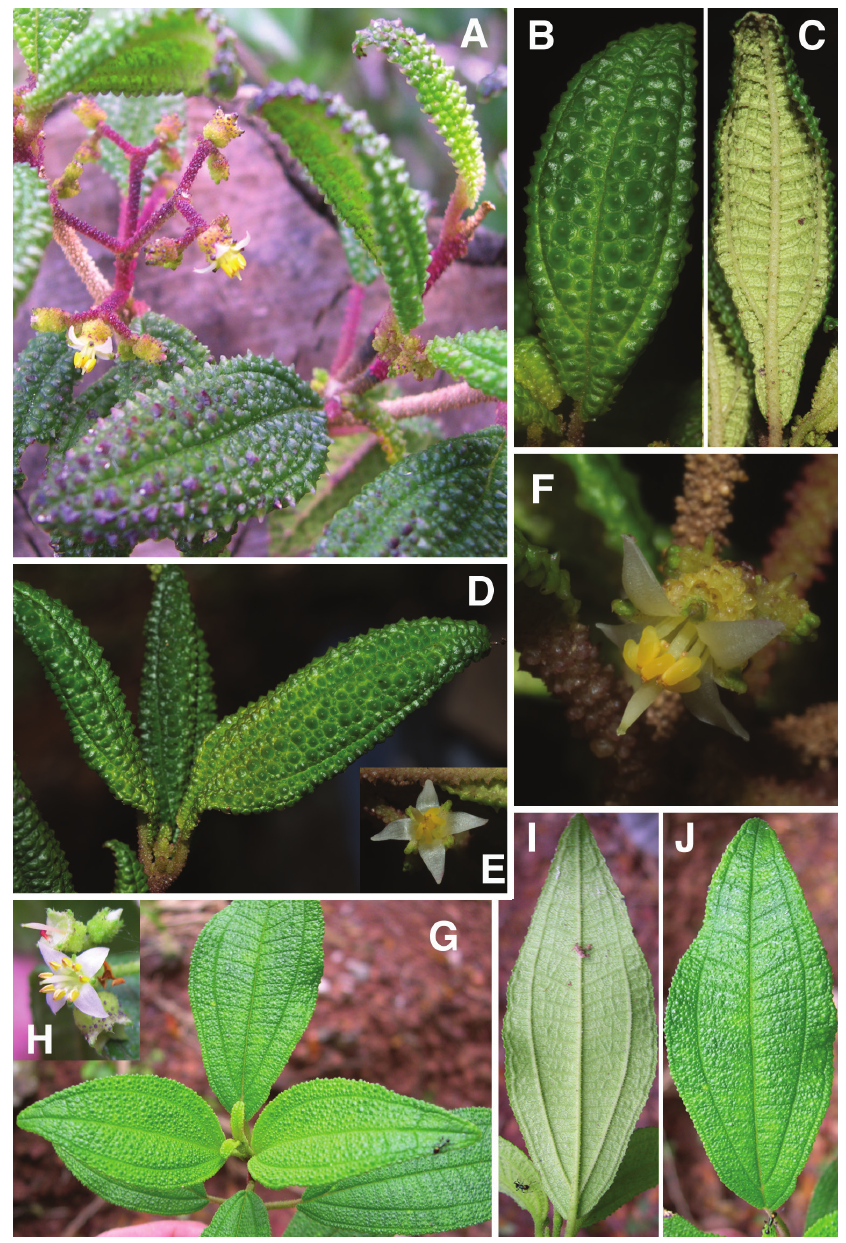
Figure 17. Photos of Miconia ottoschmidtii . A Inflorescence ( Bécquer s.n. ) B leaf adaxial surface ( Michel- angeli 2234 ) C leaf abaxial surface ( Michelangeli 2228 ) D developing leaves showing adaxial surface ( Mi- chelangeli 2228 ) E flower frontal view ( Michelangeli 2234 ) F close-up of flower ( E–F from Michelangeli 2234 ) G M. ottoschmidtii from Pinar del Río showing poorly developed bulla-based hairs H flower and immature fruit I leaf abaxial surface J leaf adaxial surface ( G–J from Bécquer HFC-82434 ). Photo A taken by E. Bécquer, B–F taken by F. Michelangeli, and G–J taken by J.R.